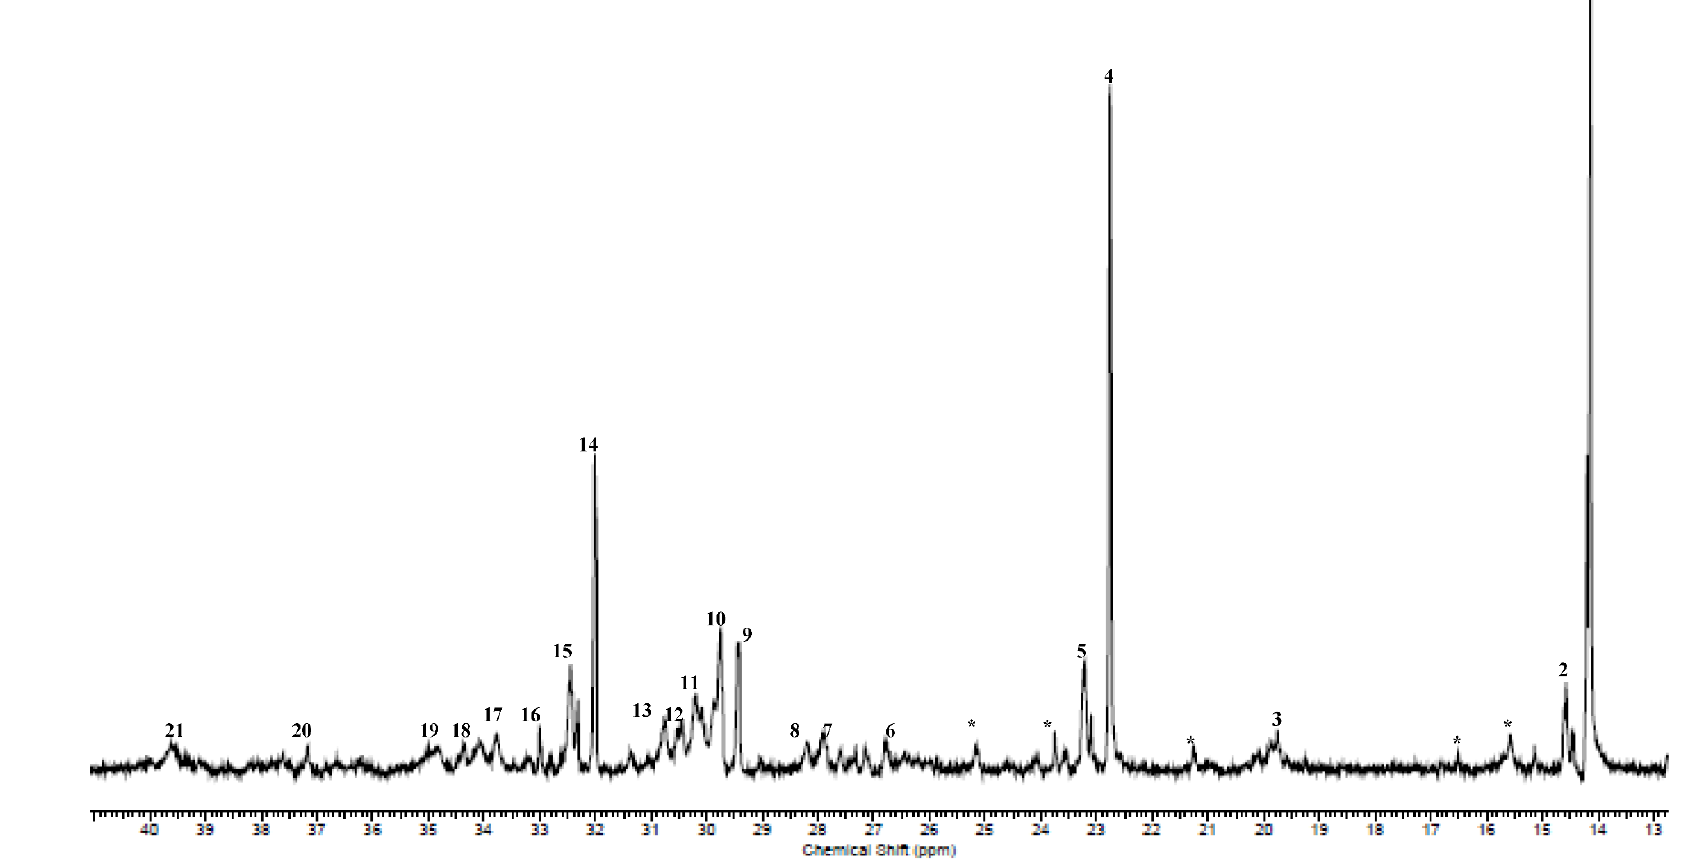
Figure 1. 13 C{ 1 H} NMR spectrum of the poly(1-hexene) obtained using (salicylaldimine)iron(III) pre-catalyst 1 (Table 1: entry 1). The peaks marked with asterisk were not assigned.